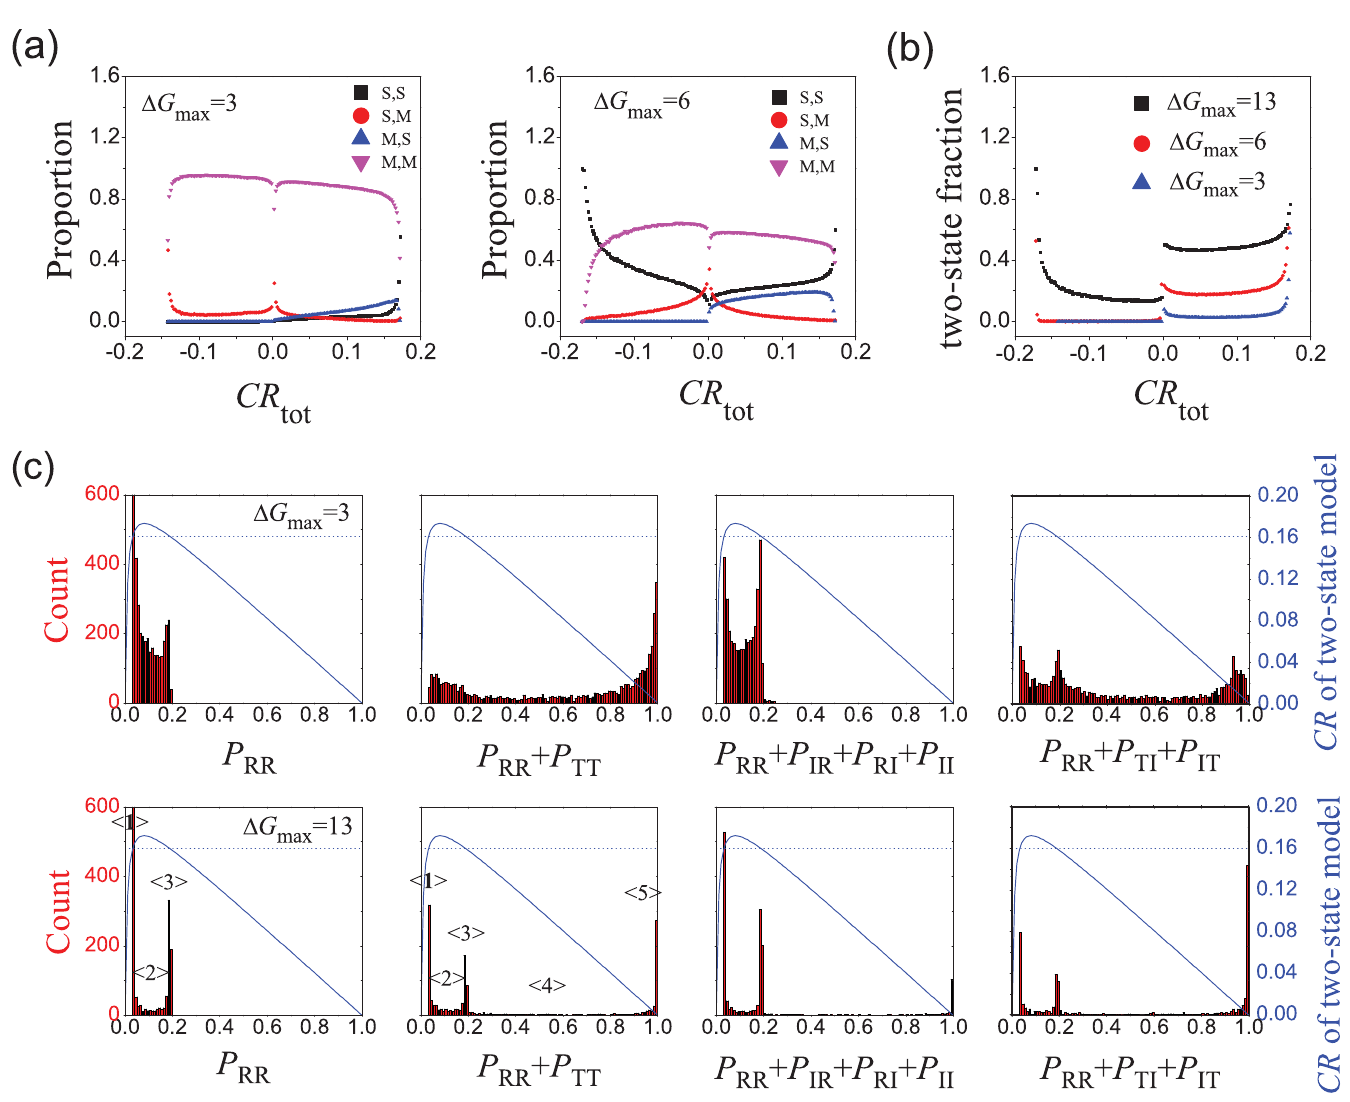
Fig 8. Interplay between different states and subsystems/pathways in the comprehensive ensemble model. The A-R binding mode is adopted. (a) Proportion of four categories [single subsystem with single pathways (S,S), single subsystem with mixing pathways (S,M), mixing subsystems with single pathways (M,S), and mixing subsystems with mixing pathways (M,M)] in systems with CR . (b) The proportion of systems with two-state transition. (c) Distribution of P RR and state probability of three subsystems ( P RR + P TT for the MWC pathway, P RR + P IR + P RI + P II for the EAM pathway, and P RR + P TI + P IT for the Other pathway) for systems with CR � 0.16. Δ G max = 3 or 13 kcal/mol. The theoretical CR ~ P RR curve (blue line) for the two-state model is also plotted using Eq (9). The horizontal dashed line represents CR =